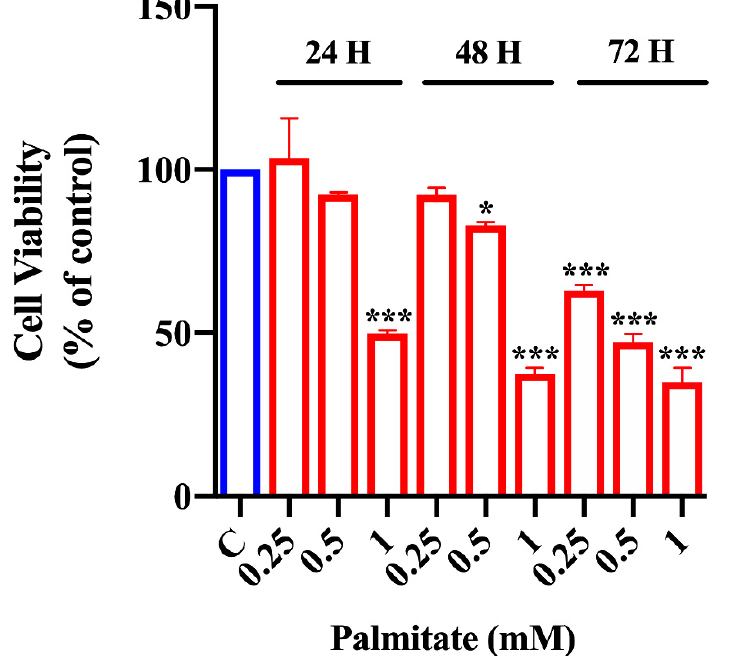
Figure 1. Effect of palmitate on cell viability in intestinal organoids. MTT assay in intestinal organoids exposed to increasing concentrations of palmitate (0.25, 0.5 and 1 mM) after 24, 48, and 72 h ( n = 6). Data are expressed as means ± SD of 570 nM absorbance to % of controls. One-way ANOVA followed by Bonferroni test: * p < 0.05, *** p < 0.001 compared to controls.